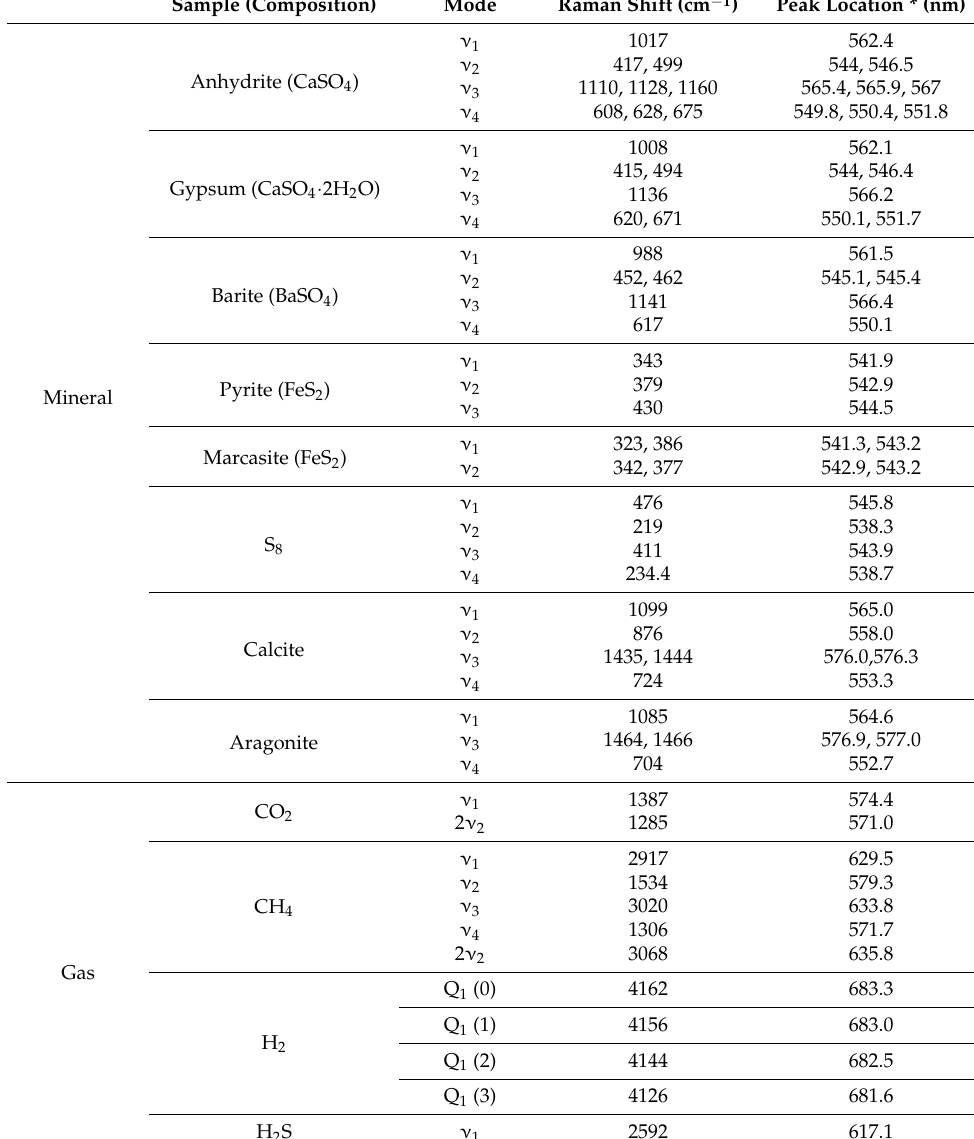
Table 3. The Raman shift and peak location of the typical targets in deep sea